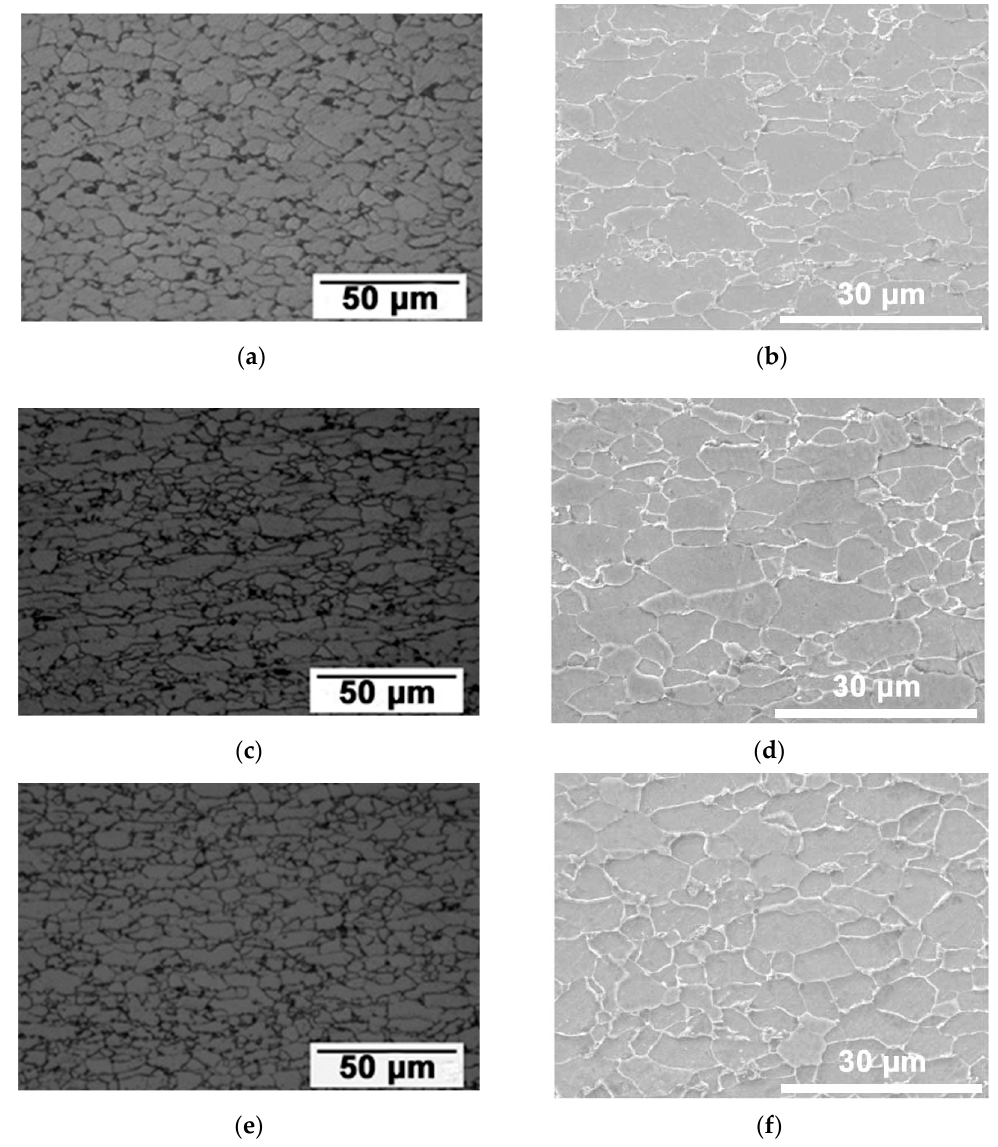
Figure 4. Microstructure of samples of the batches: ( a , b ) No. 1-1; ( c , d ) No. 2-1; ( e , f ) No. 2-2.